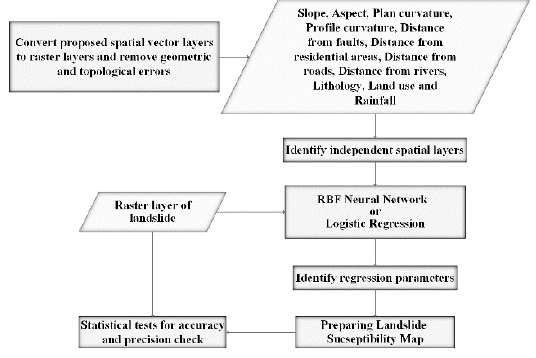
Figure 1. Research